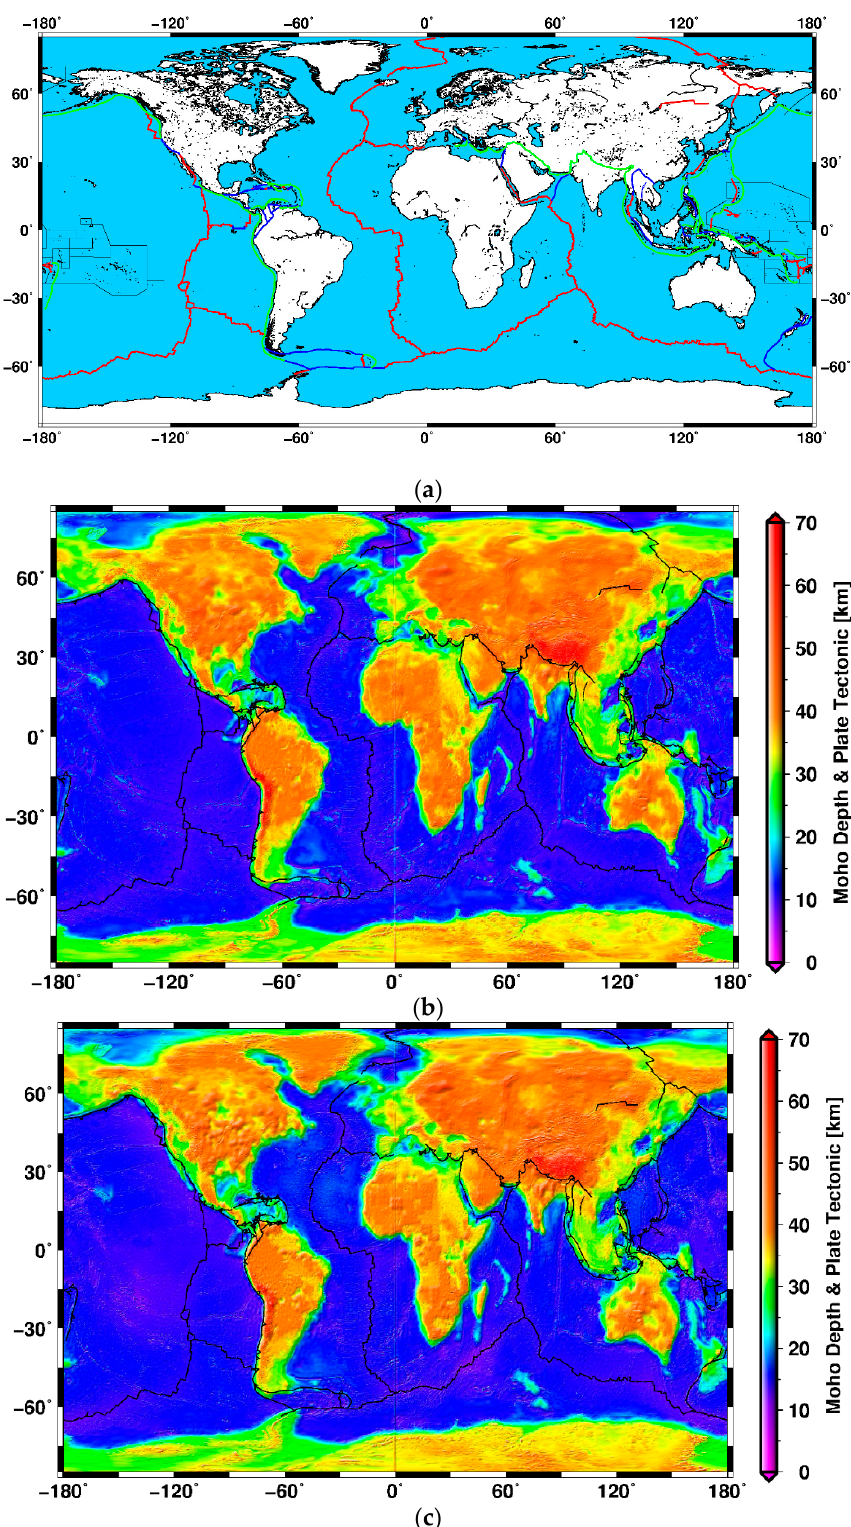
Figure A4. The Moho geometry and global tectonic configuration: ( a ) The Earth’s tectonic margins (red = divergent plate boundary, green = convergence plate boundary, and blue = transform plate boundary), ( b ) the HRCM Butterworth filter solution including tectonic configuration, and ( c ) the HRCM spectral combination solution including tectonic configuration.